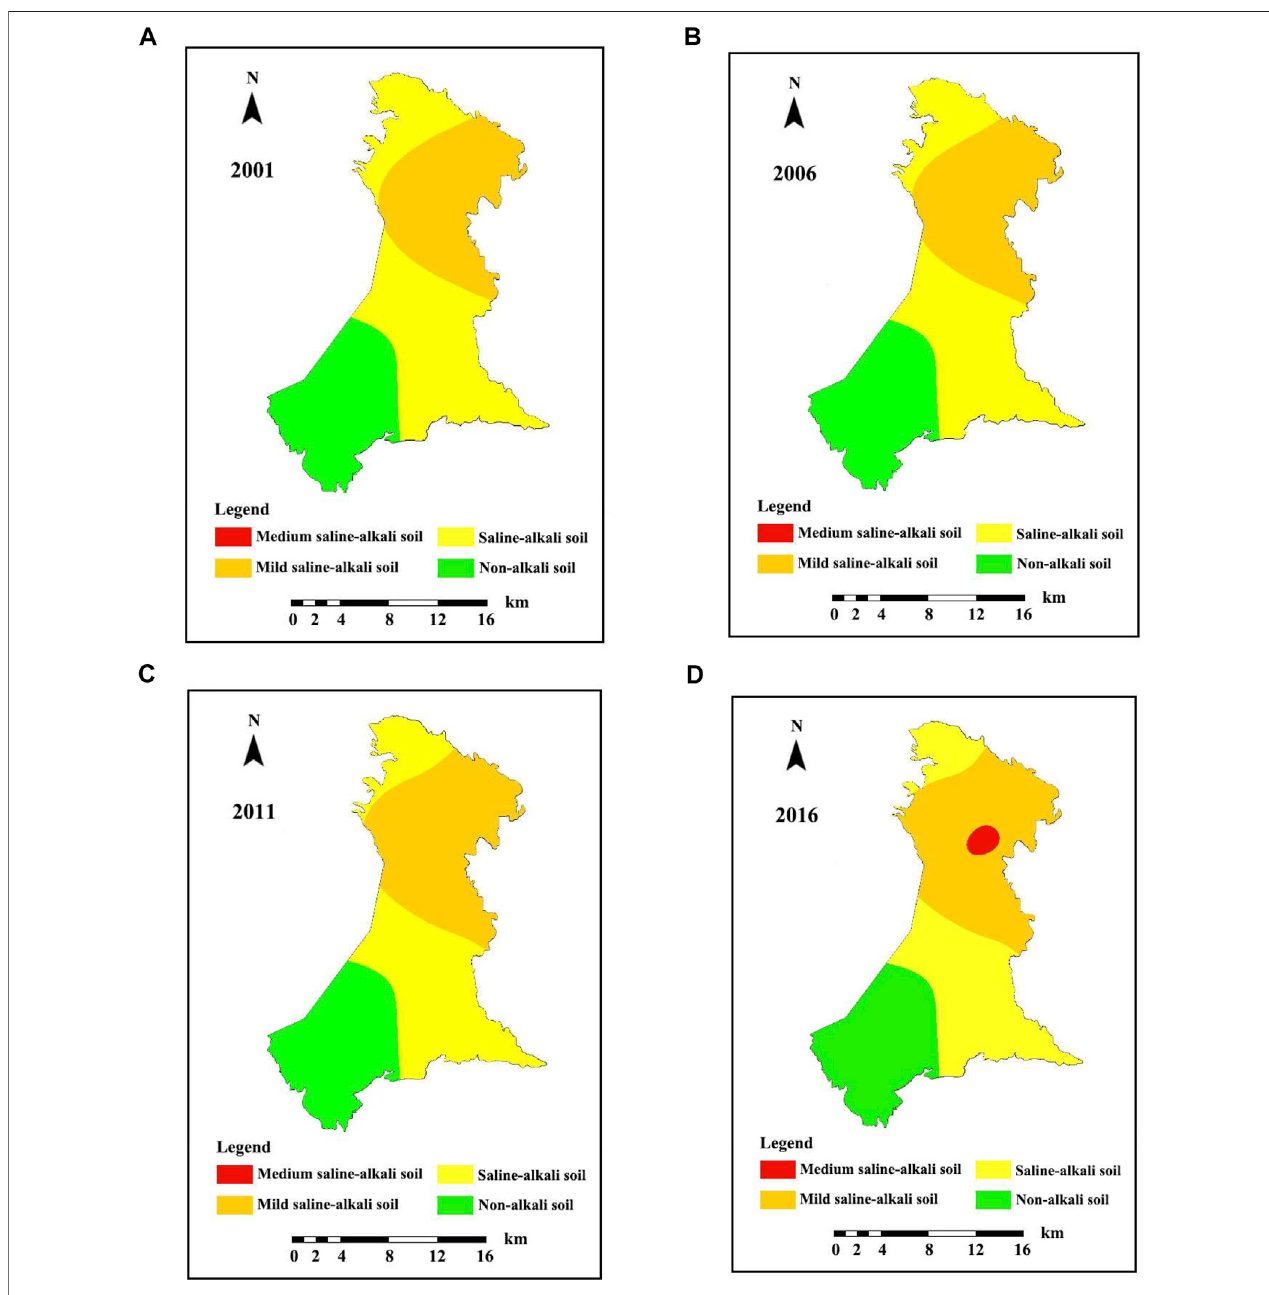
FIGURE 4 | Spatial distribution of saline – alkaline soil in different years [ (A) 2001; (B) 2006; (C) 2011; (D) 2016].